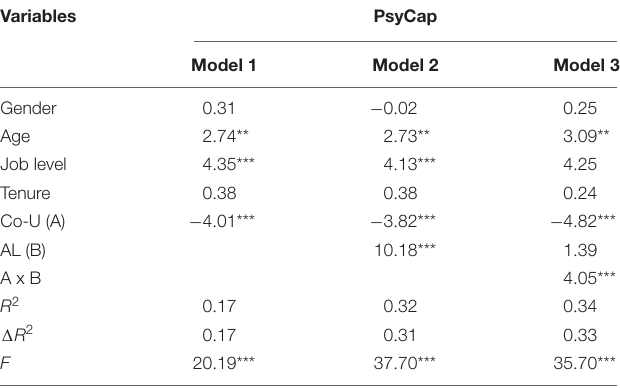
TABLE 5 | Results of hierarchical multiple regression testing Hypothesis 3.